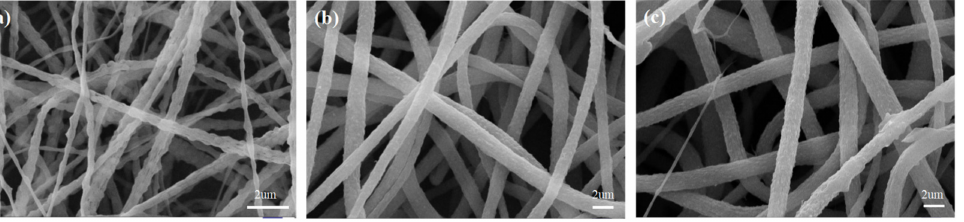
Figure 2. SEM images of PVDF nanofiber membranes with different concentrations: ( a ) 8 wt%, ( b ) 10 wt%, and ( c ) 12